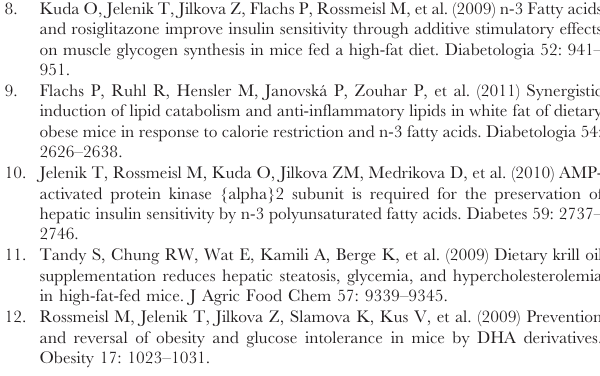
Table S6 Fatty acid composition of total phospholipids in the liver from the ‘prevention study’. Fatty acid composition was analyzed in the total phospholipid fraction extracted from the liver. The results (mol %) are expressed as means 6 SEM ( n = 4). a,b,c Significant differences (ANOVA) compared with cHF, cHF + v 3TG, and cHF + v 3PL (10 g per kg diet), respectively. SFA, saturated fatty acids; MUFA, mono- unsaturated fatty acids; PUFA, polyunsaturated fatty acids. –, # 0.1% (detection limit). Table S7 Fatty acid composition in total lipids from adipose tissue in the ‘prevention study’. Fatty acid composition was analyzed in the total lipid fraction extracted from abdominal adipose tissue (epididymal fat depot). Results (mol %) are expressed as means 6 SEM ( n = 7). a,b,c Significant differences (ANOVA) compared with cHF, cHF + v 3TG, and cHF + v 3PL (10 g per kg diet), respectively. MUFA, monounsat- urated fatty acids; PUFA, polyunsaturated fatty acids. –, # 0.1% (detection limit). Table S8 TOF-SIMS analysis of lipid fractions in the liver from the ‘prevention study’. Various lipid species were analyzed in the liver by the TOF-SIMS method. Data are expressed as the (cHF + v 3TG)/cHF and (cHF + v 3PL)/cHF normalised signal intensity ratios for lipid signals, originating from mice fed the control diet (cHF) and from mice fed the cHF-based experimental diets supplemented with the EPA and DHA concentrate either in the form of triglycerides (cHF + v 3TG) or marine phospholipids (cHF + v 3PL). DAG, diacylglycerol; PC, phosphatidylcholine; PE, phosphatidylethanolamine; PI, phospha- tidylinositol. Table S9 TOF-SIMS analysis of lipid fractions in adipose tissue from the ‘prevention study’. Various lipid species were analyzed in epididymal adipose tissue by the TOF- SIMS method. Data are expressed as the (cHF + v 3TG)/cHF and (cHF + v 3PL)/cHF normalised signal intensity ratios for lipid signals, originating from mice fed the control diet (cHF) and from